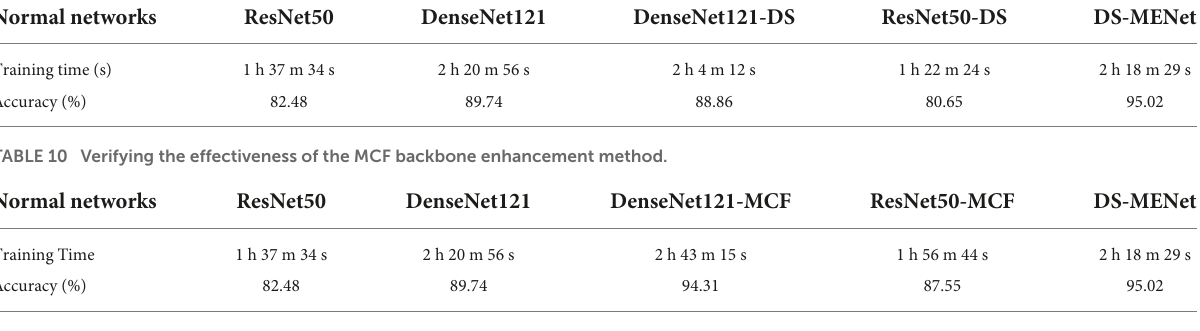
TABLE 11 Ablation experiment results.